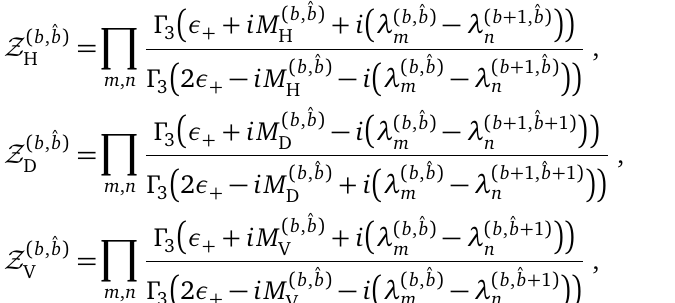
orbifold theory. Opposite edges are